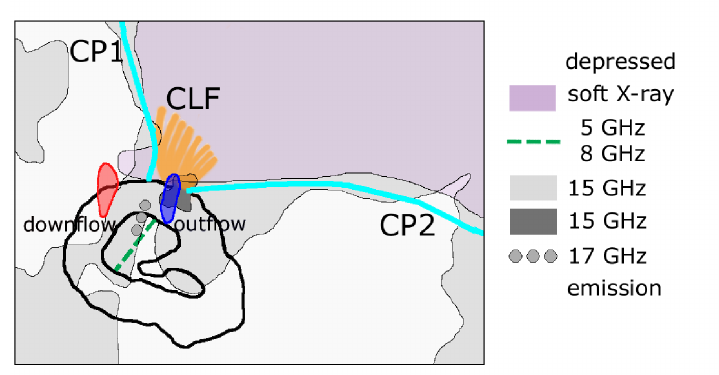
Fig. 9. The schematic picture of the observational features (depressed emission and cool loop fan) indicating the peculiarities (plasma outflow and the open-field regions of two coronal partings) near the sunspot (the black thick contours of umbra and penumbra). CP1 and CP2 refer to the median lines of two open-field regions in panel